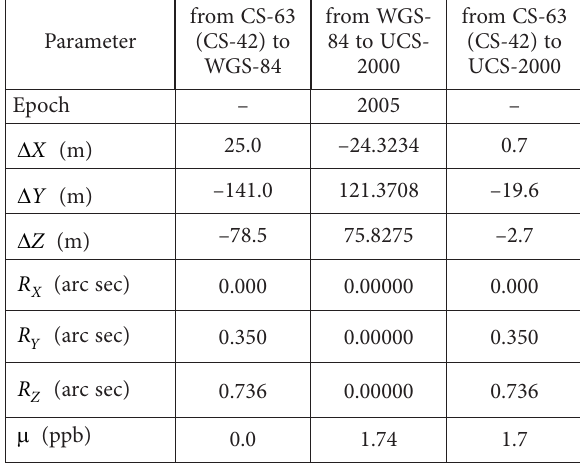
Table 1. Helmert parameters for the transformation of coordinates between the CS-63 (CS-42), WGS-84,